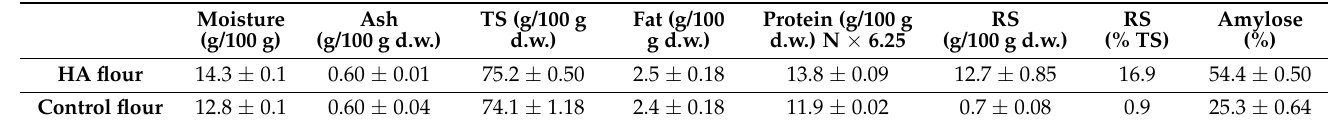
Table 1. Chemical composition of flours (mean value ±